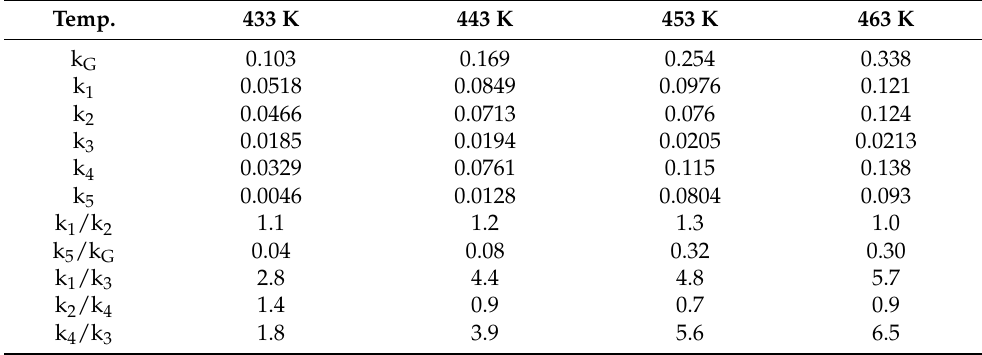
Table 2. Kinetic parameters for the conversion of glucose into HMF and furfural at different temperatures. Temp. 433 K 443 K 453 K